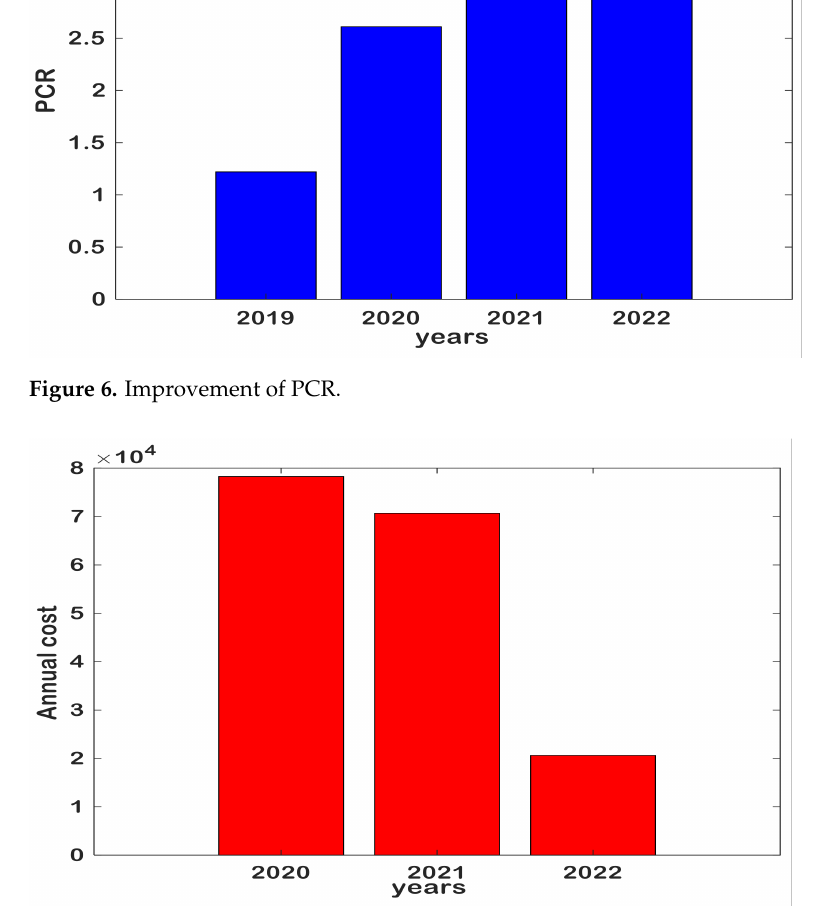
Figure 7. Annual maintenance cost during three years. Table 5. Total annual PCR and its maintenance